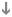
Conceptual model showing the likely effects of CO2 concentration, current velocity and shoot density on gross production (GPP) and respiration (R).(↑) Increase, (↓) Decrease, (↑↑) Significant increase. Current pH means the actual sea pH (pH = 8.1). Forecasted pH means the ocean acidification scenario forecasted by the Intergovernmental Panel on Climate Change (pH = 7.65).